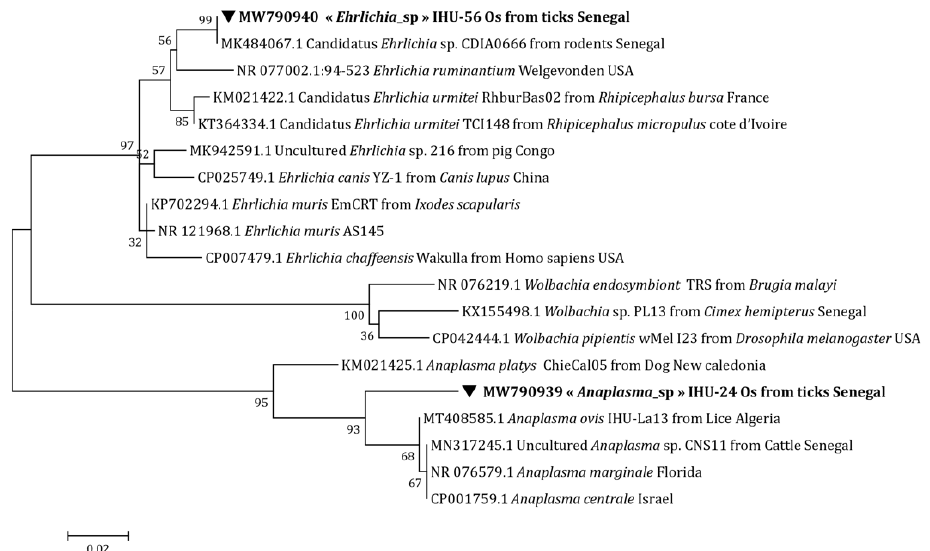
Figure 2. Anaplasmataceae maximum-likelihood phylogenetic tree targeting the partial 513-bp 23S gene.